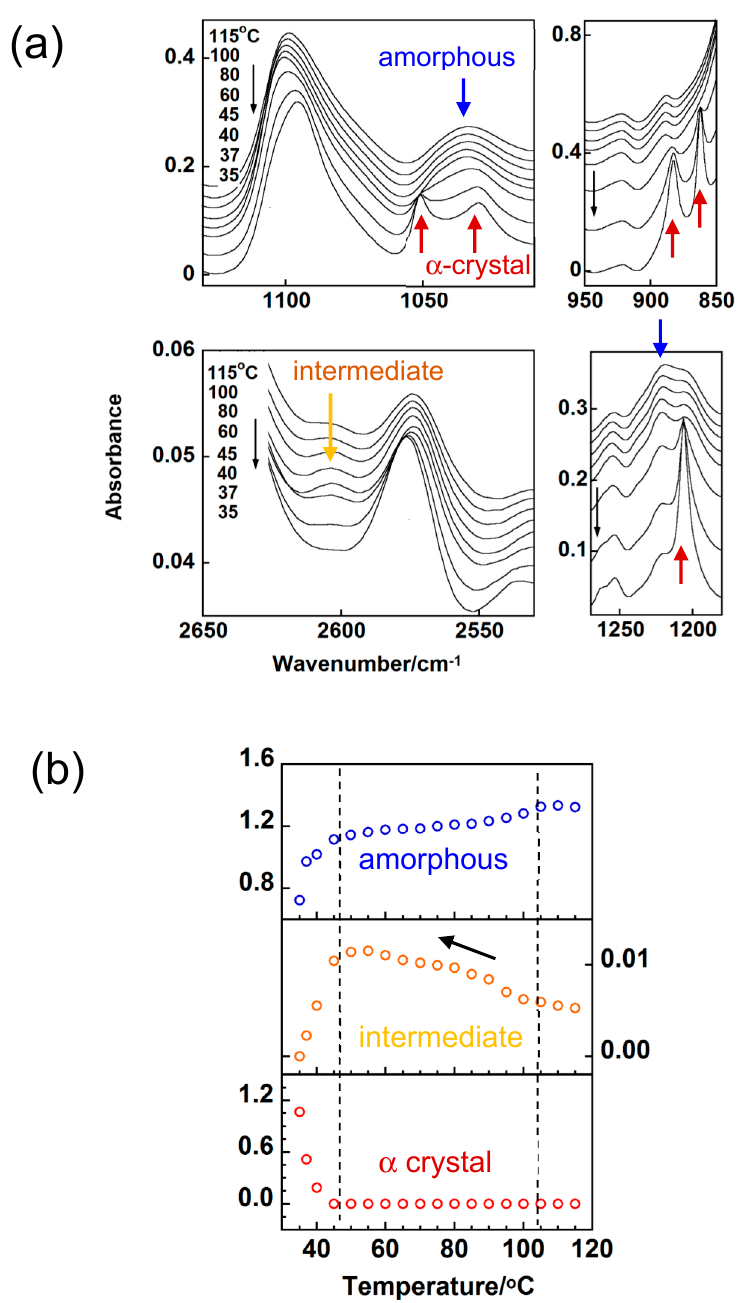
Figure 7. Temperature dependence of ( a ) IR spectra and ( b ) integrated intensity of the amorphous, intermediate and crystalline ( α ) bands of trans-1,4-polyisoprene measured in the cooling process from the melt [36].